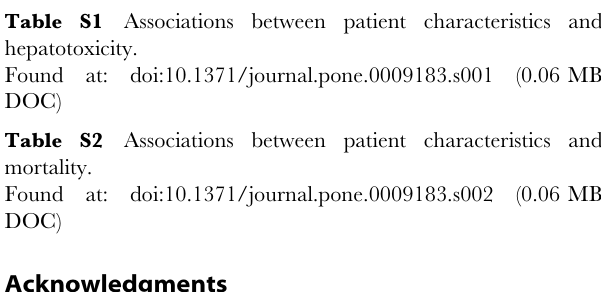
Table S1 Associations between patient characteristics and hepatotoxicity.